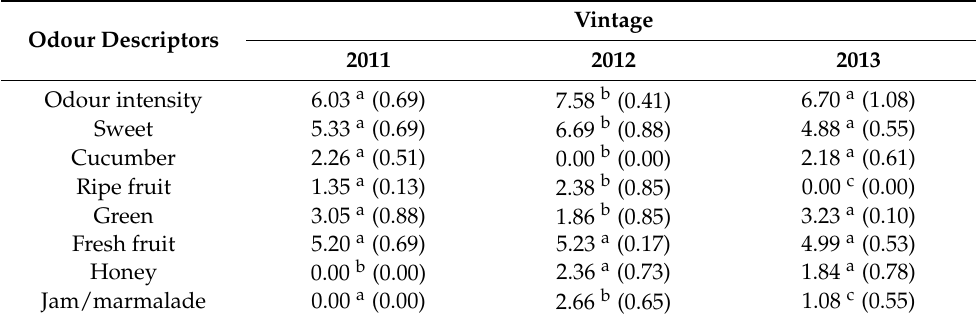
Table 4. Olfactive profile of La Mancha Trujillo melons scores of 15 judges and standard deviations (two